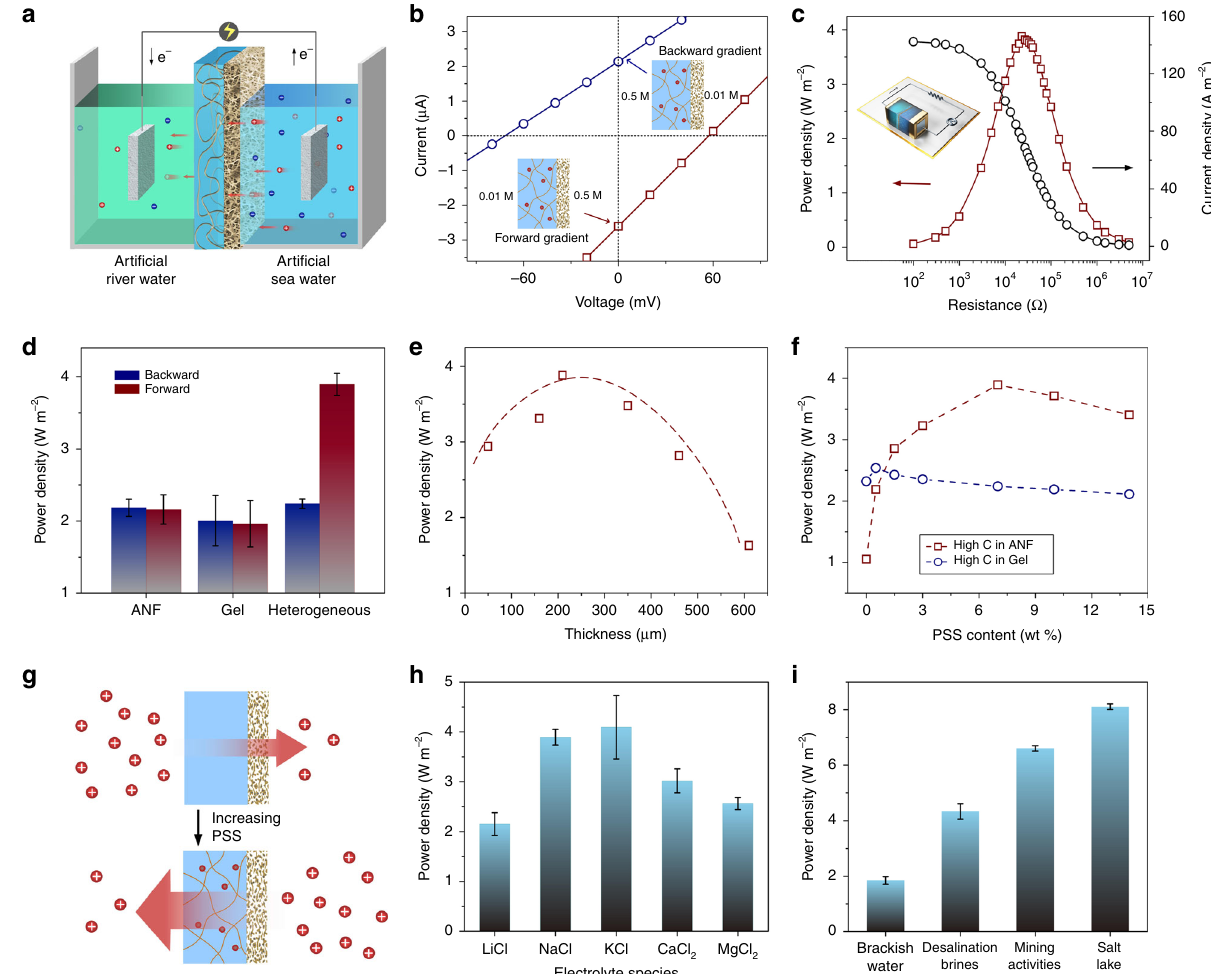
Fig. 4 Osmotic energy conversion behavior. a Schematic of the osmotic energy conversion process. b I – V curves of the hybrid membrane under forward and backward NaCl concentration gradient. c The power generation on the external load under forward concentration gradient. Inset: schematic illustration of the experimental setup for the measurement of osmotic power with electrical resistor. d Comparison of the power density of the separate ANF membrane, gel membrane, and the heterogeneous membrane when mixing 0.5 M/0.01 M NaCl. e , f In fl uence of the thickness of the polyelectrolyte hydrogel membrane ( e ) and the content of polyelectrolyte ( f ) on the power density. The concentration gradient is 0.5 M/0.01 M NaCl. g Schematic of the reversion of dominant diffusion direction upon increasing the dosage of polyelectrolyte. h Power generation under a series of electrolyte species. i Power generation under a series of arti fi cial water resources including brackish water, desalination brines, brines from mining activities, and water from salt lake. Error bars represent SD ( n